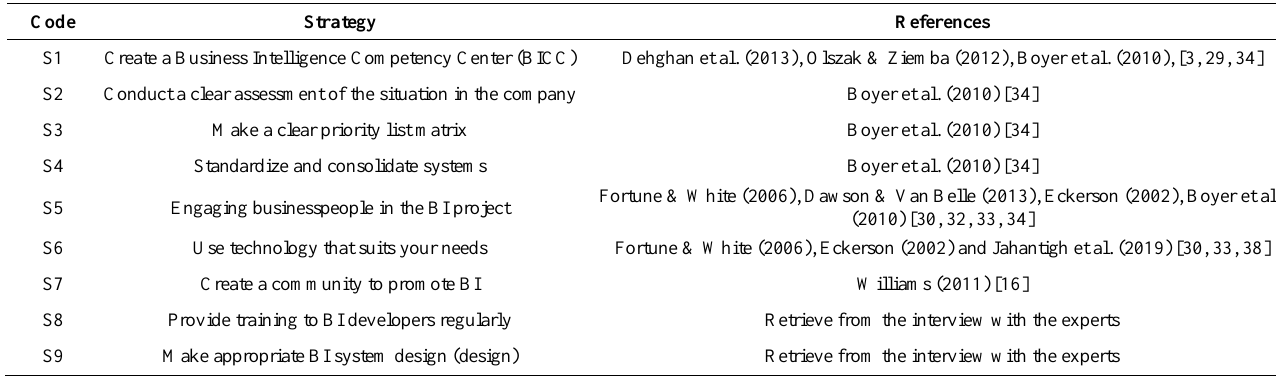
Table 2. Development